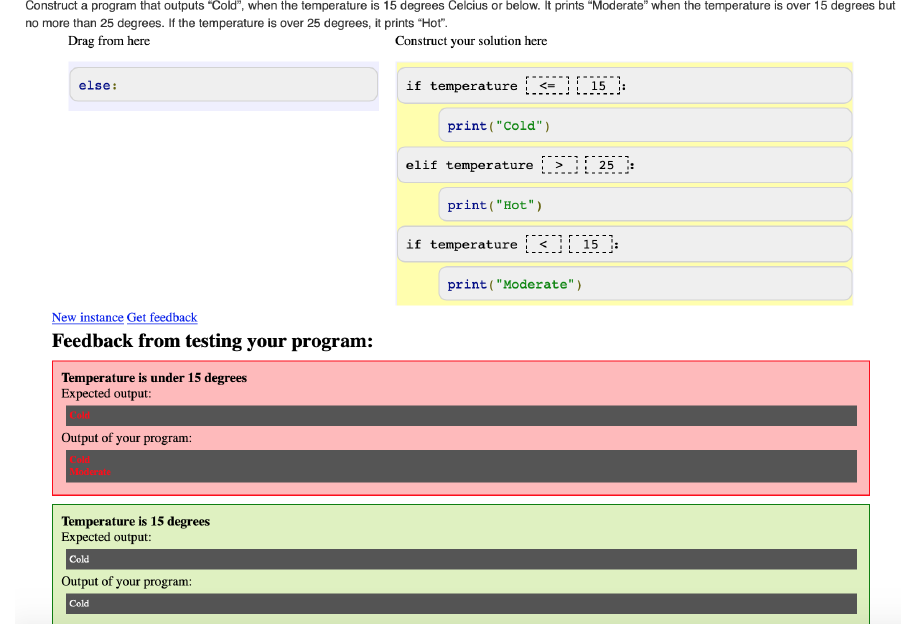
Figure 5. An instance of ACOS Parson’s problem, which asks students to construct a program to indicate weather conditions based on the